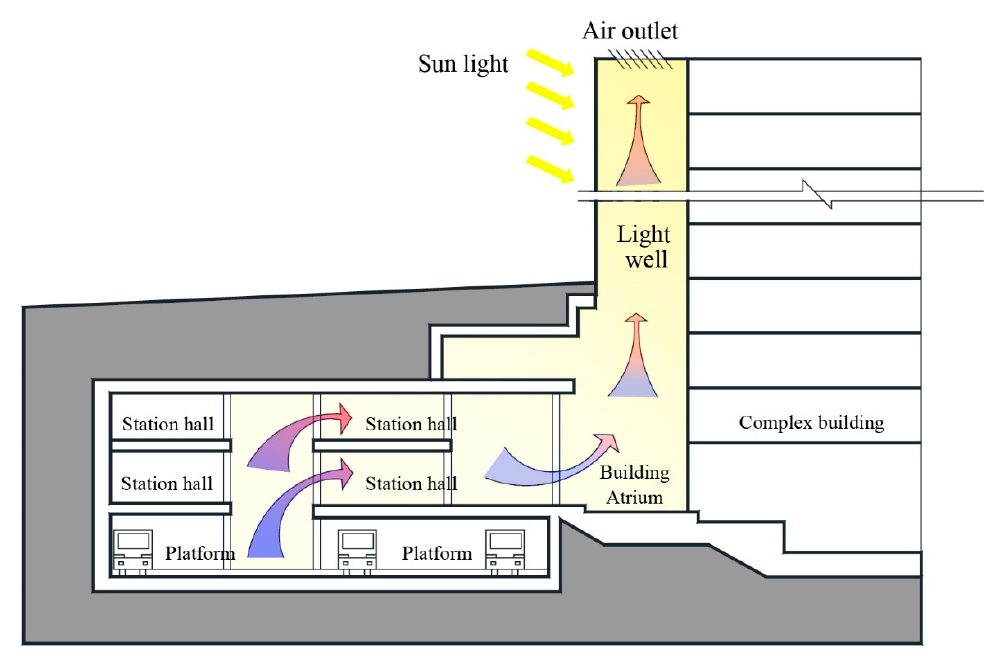
Figure 20. Sketch map of lighting through hot pressing the ventilation in a composite space system.